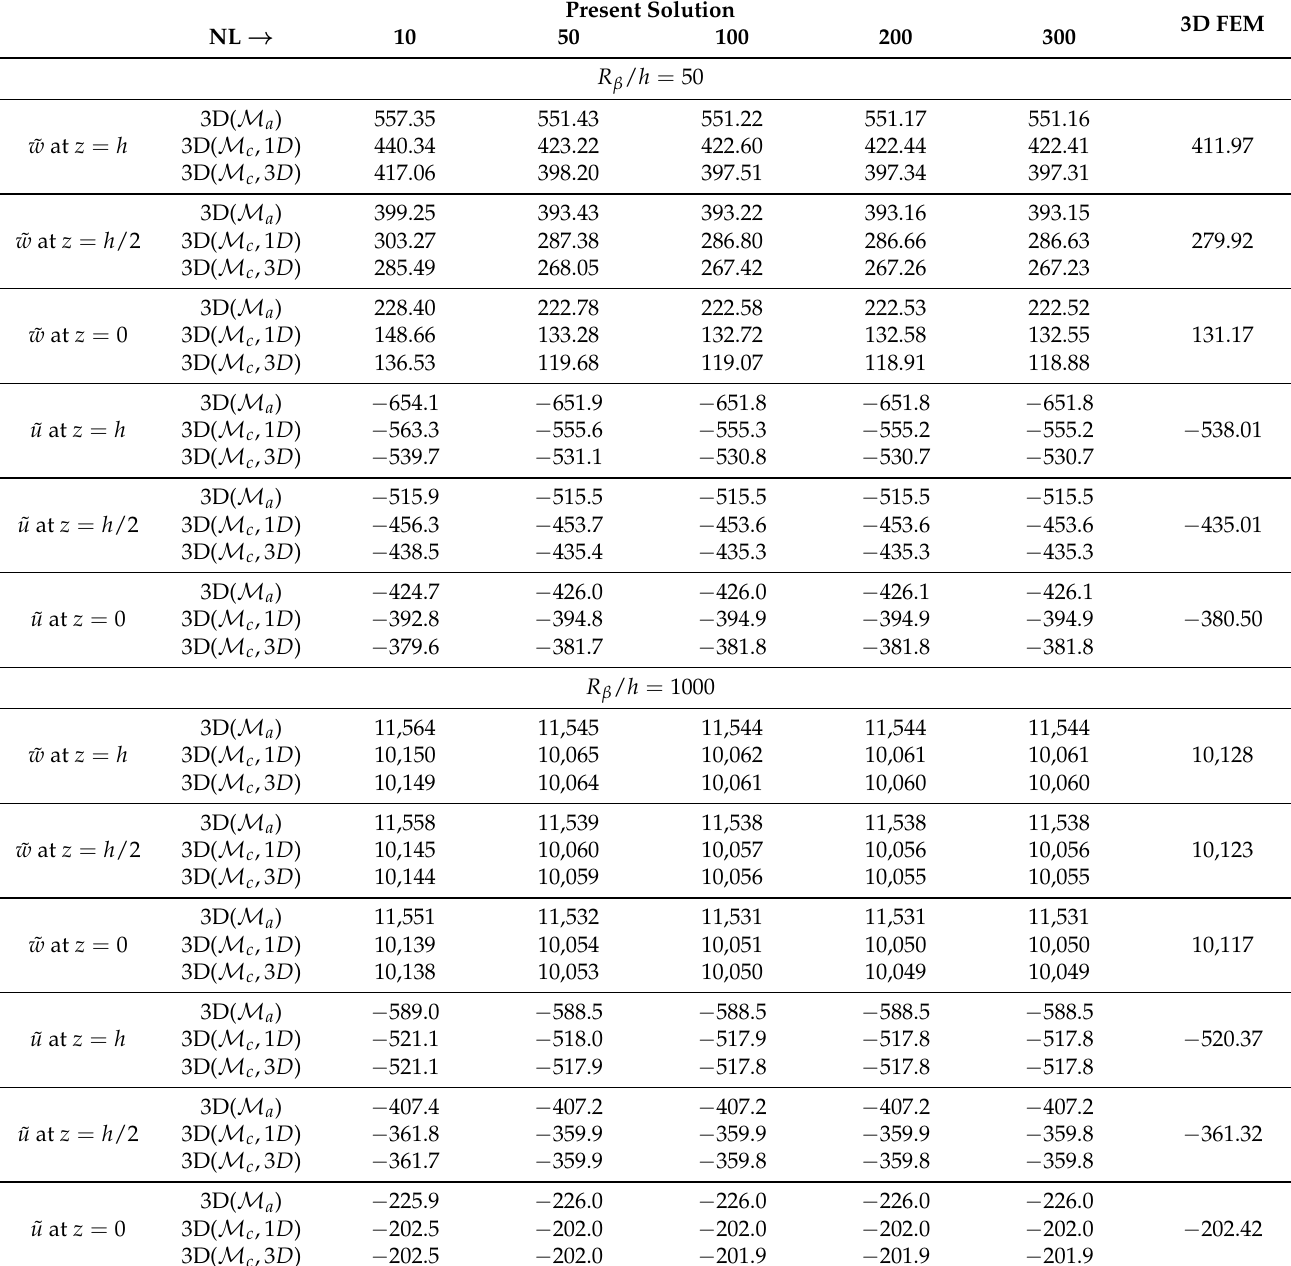
Table 4. Fourth assessment. One-layered FGM cylindrical shell ( R β = 10 m) featuring different thickness ratios. The geometry, materials, and FGM power law are the same as the third assessment. The thermal load is substituted by an external moisture content acting on the top ( M t = 1.0%) and bottom ( M b = 0.5%) surfaces; m = n = 1. The reference solution is the 3D FE model, already validated in the previous assessment. The results of the present solution are obtained with N = 3 and for a varying number of mathematical layers